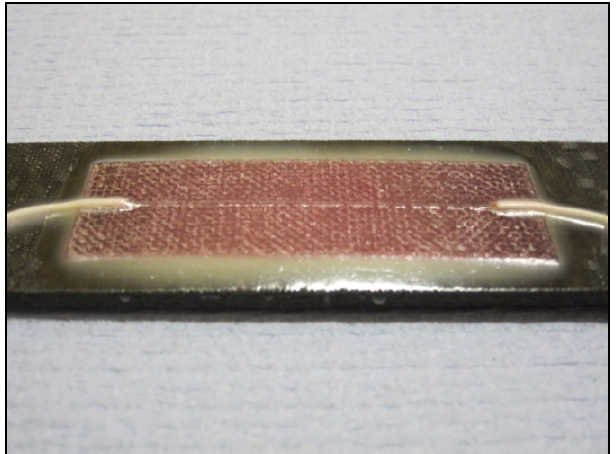
Figure 2. Sensor patch applied to cfrp